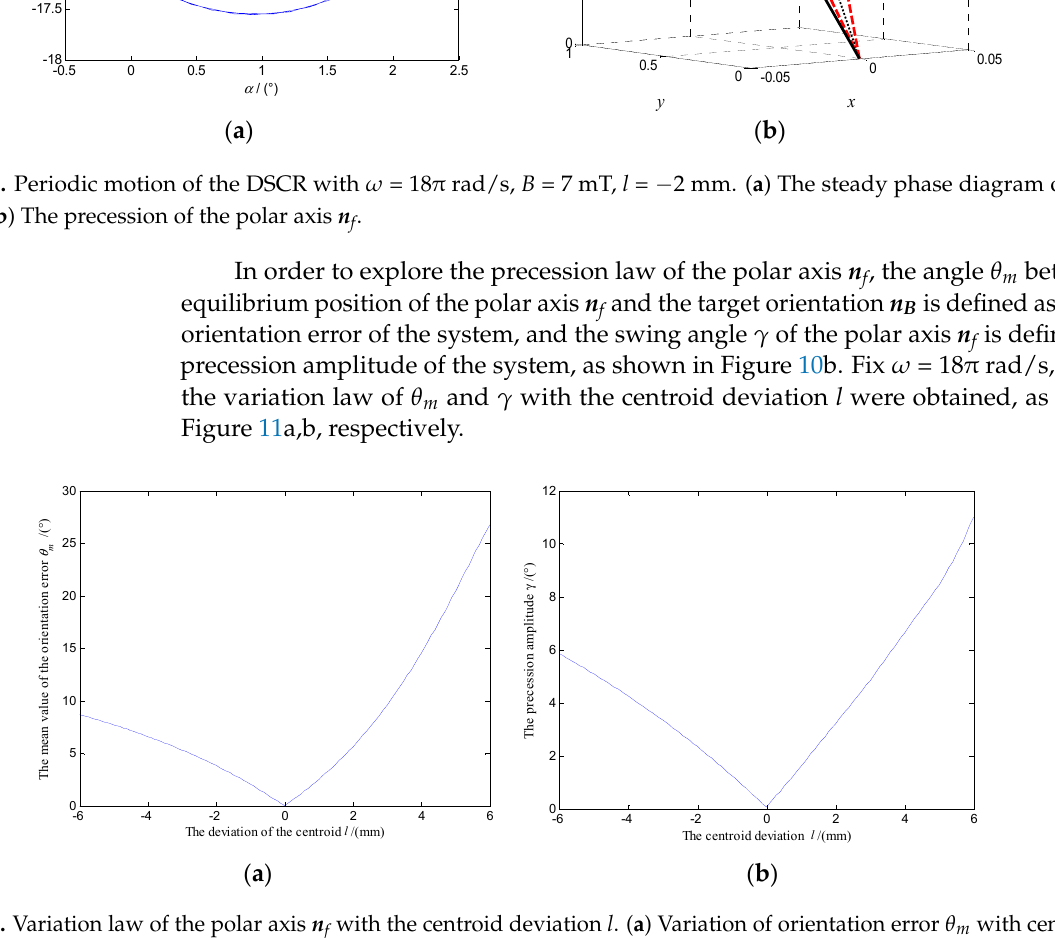
( b ) Figure 12. Variation law of the polar axis n f with ω and B. ( a ) Variation of orientation error θ m with ω and B ; ( b ) Variation of precession amplitude γ with ω and B . Figure 12a shows that the mean orientation error of the system can be reduced by increasing ω and B simultaneously. While Figure 12b shows that increasing ω and de- creasing B can significantly reduce the precession amplitude of the system .